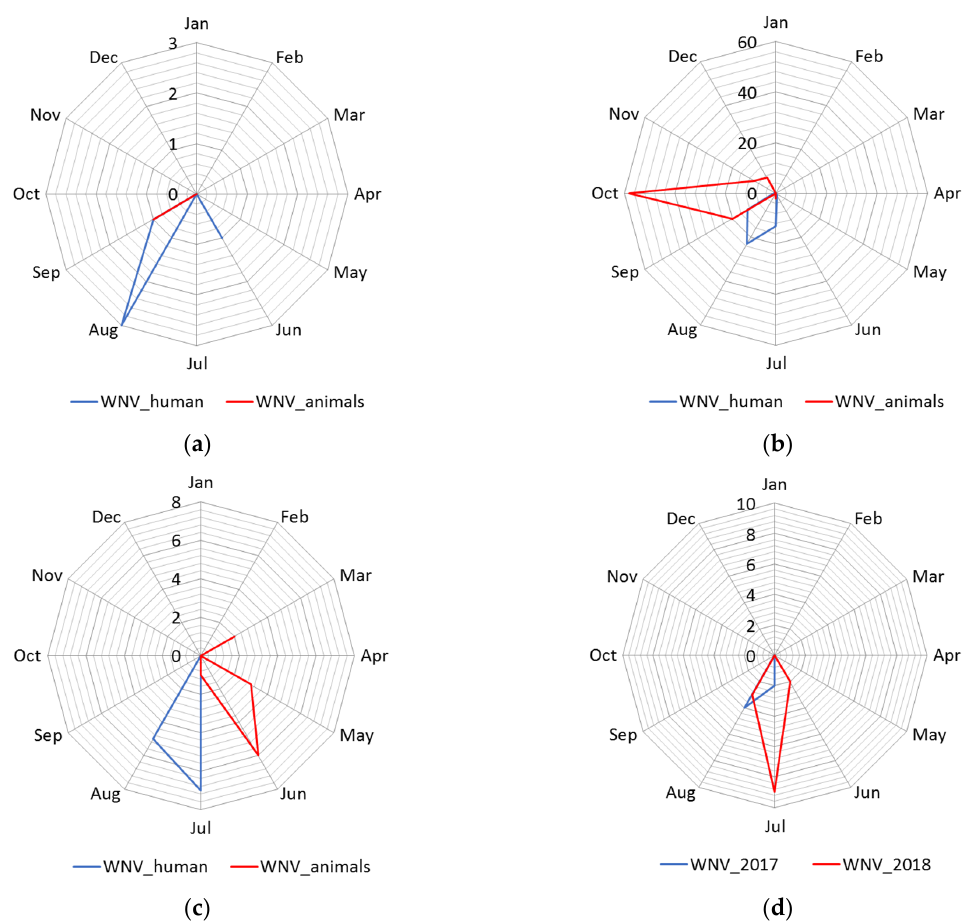
Figure 3. Seasonality of the West Nile virus WNV infection registered in South Banat District in different months: ( a ) Cases of WNV infection in humans and animals in 2017; ( b ) cases of WNV infection in humans and animals in 2018; ( c ) cases of WNV infection in humans and animals in 2019; ( d ) WNV infected mosquitoes in 2017 and 2018.